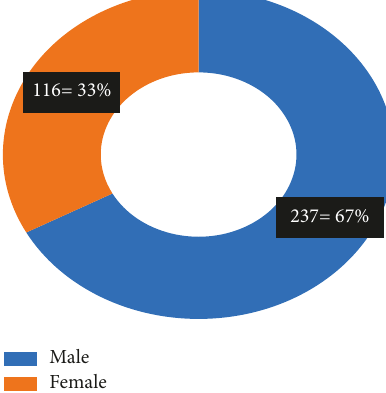
Figure 1: Sample distribution of the participants according to their gender.